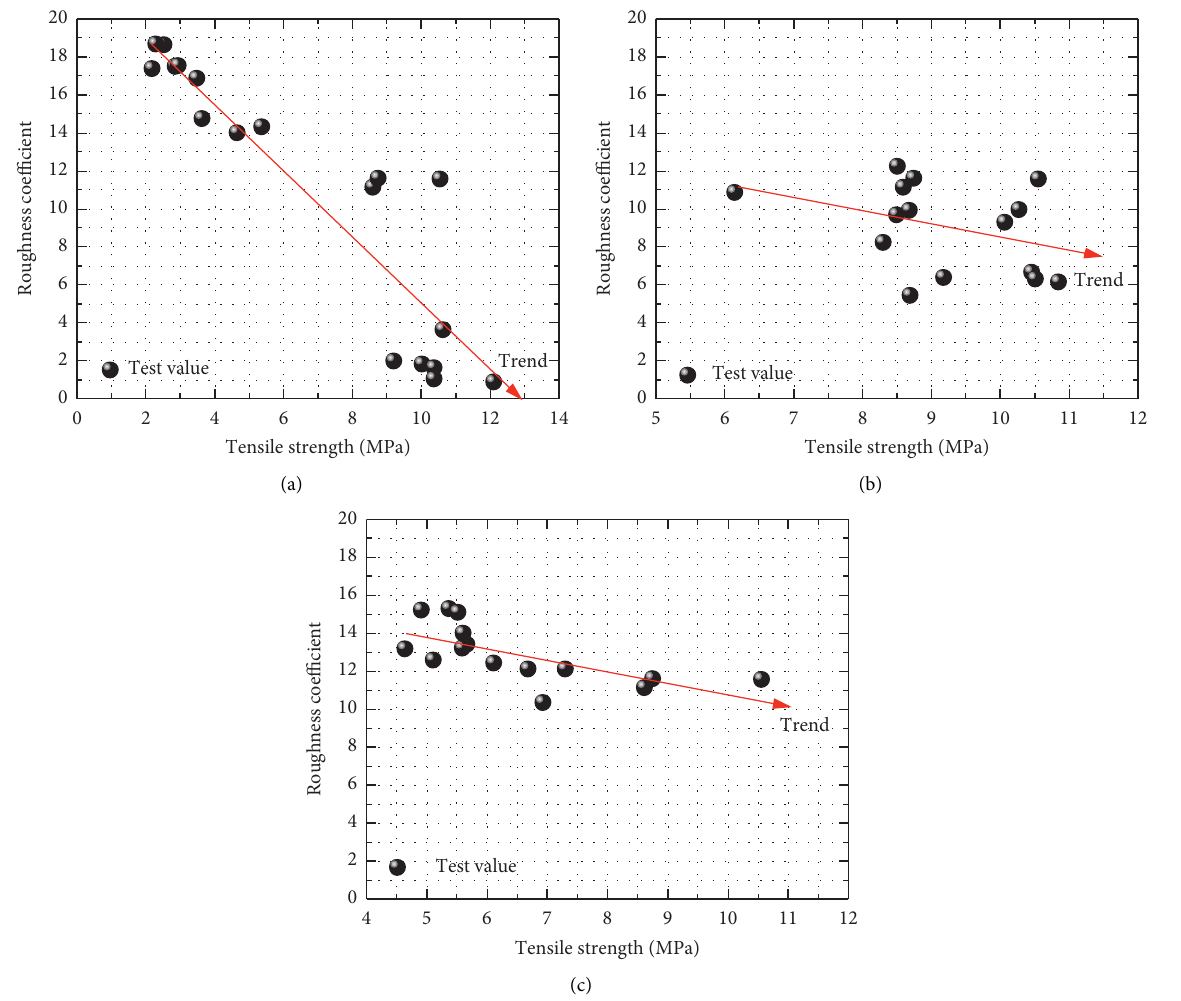
Figure 13: The relationship between the tensile strength and the roughness coefficient. (a) HDR temperature. (b) Water temperature. (c) The number of heating-cooling